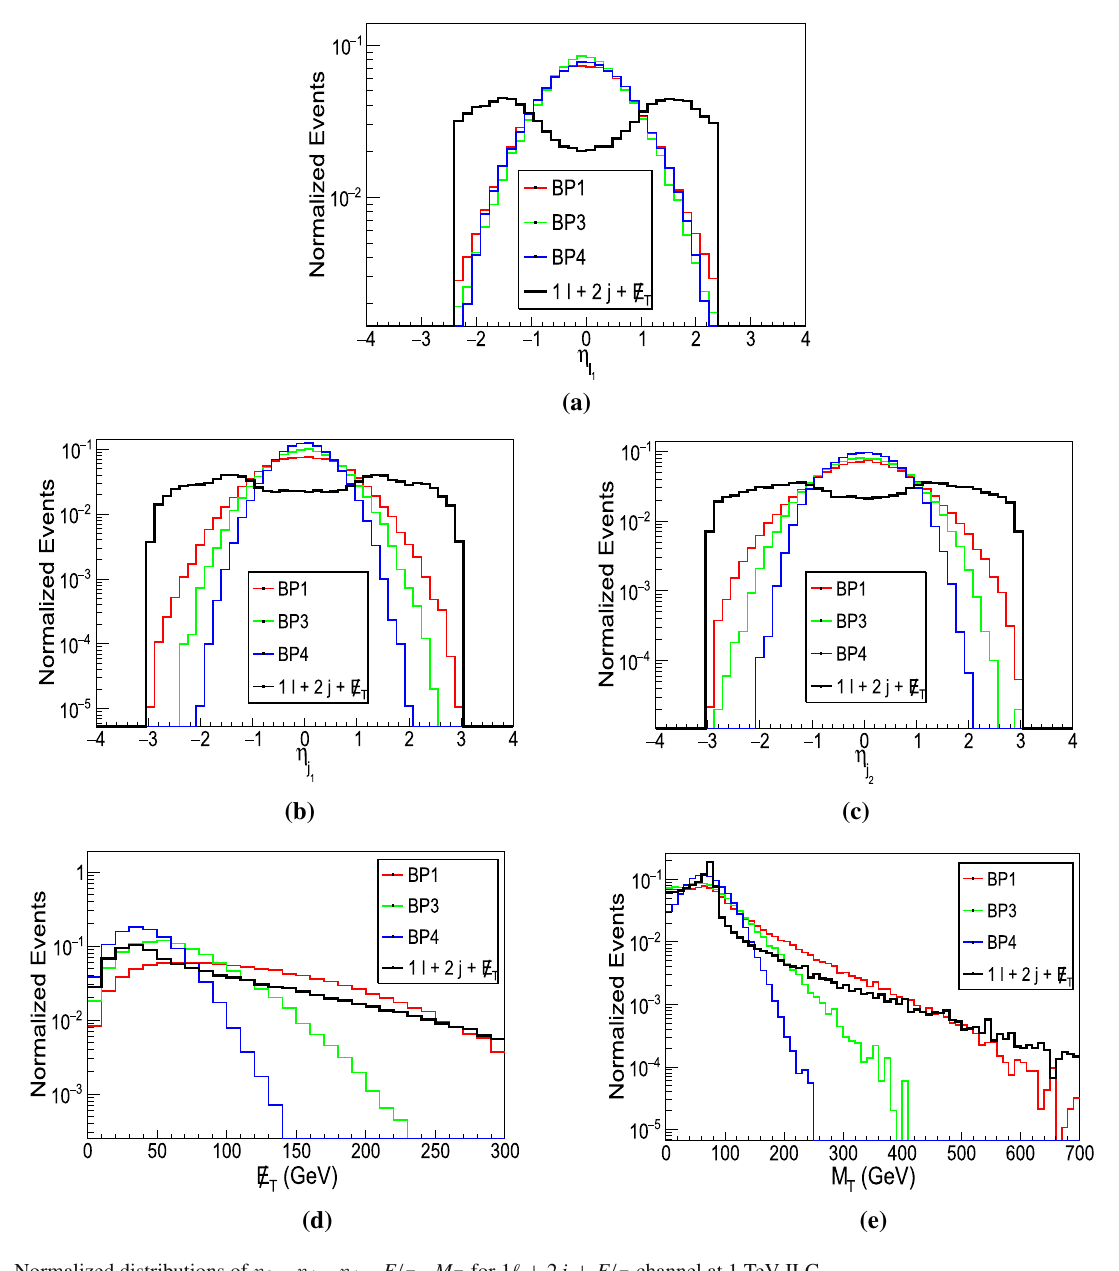
T channel at 1 TeV ILC